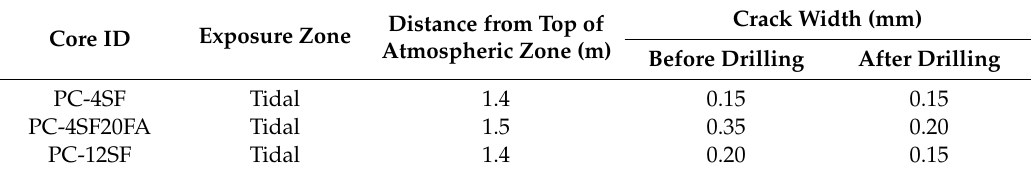
Table 3. Exposure and surface crack width of the investigated concrete cores.